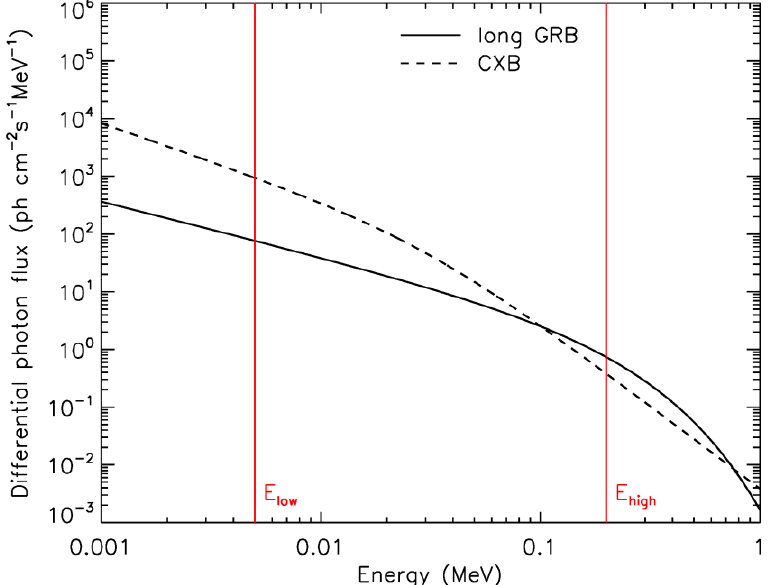
Figure 8. Differential photon flux of a typical long GRB (fluence spectrum) and CXB as a function of X-ray energy. Energy limits E low and E high , which are 5 and 200 keV here, respectively, define the dynamic range of the detector. The fluxes are multiplied by a factor of 0.5, which approximately corresponds to the fraction of photons blocked by the UBAT ’ s coded mask. The CXB flux is also multiplied by the detector ’ s FOV of 1.85 sr.